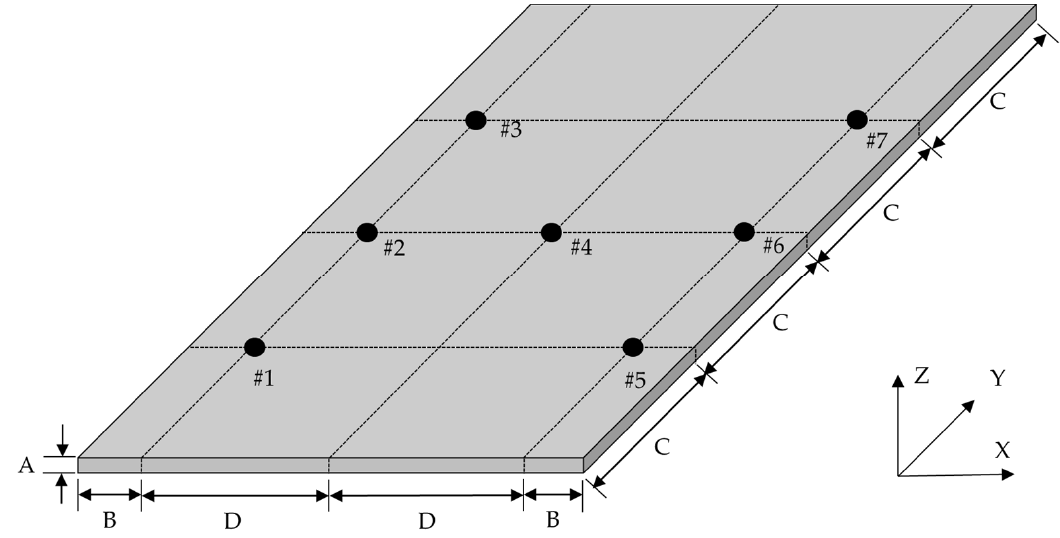
Figure 1. Configuration of simple rectangular specimen and sensor attachment locations: A: 3 mm, B: 10 mm, C: 37.5 mm, D: 30 mm.